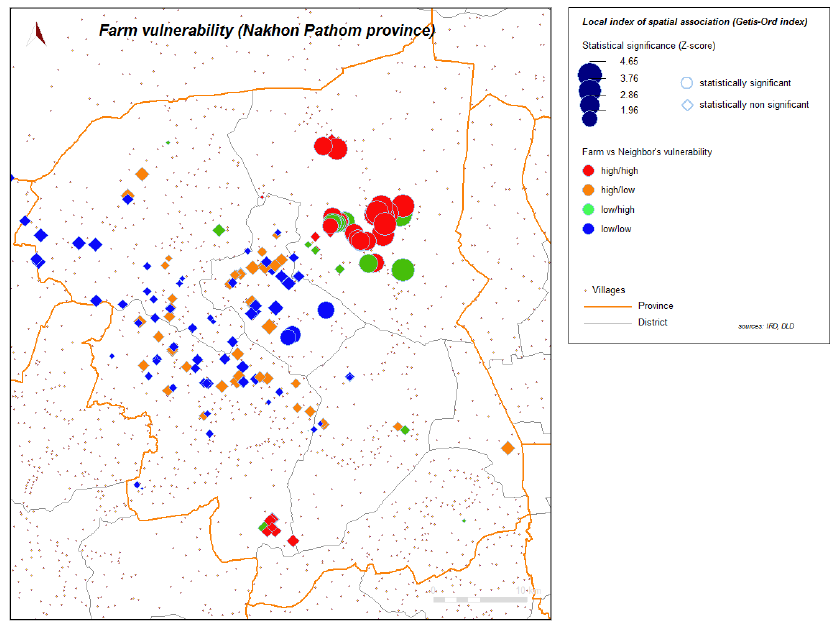
Figure 7. Local index of spatial association (Getis-Ord) for vulnerability, farms sector 2 and 3, Nakhon Pathom province,